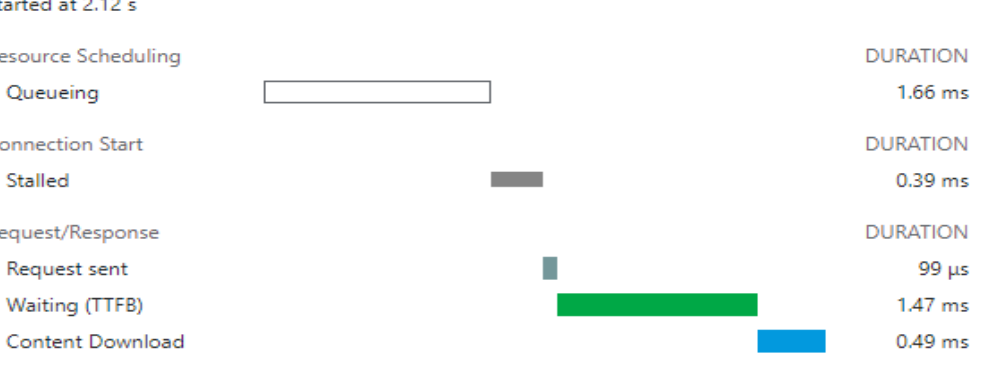
Figure 5. Simulation without any loading — first page.